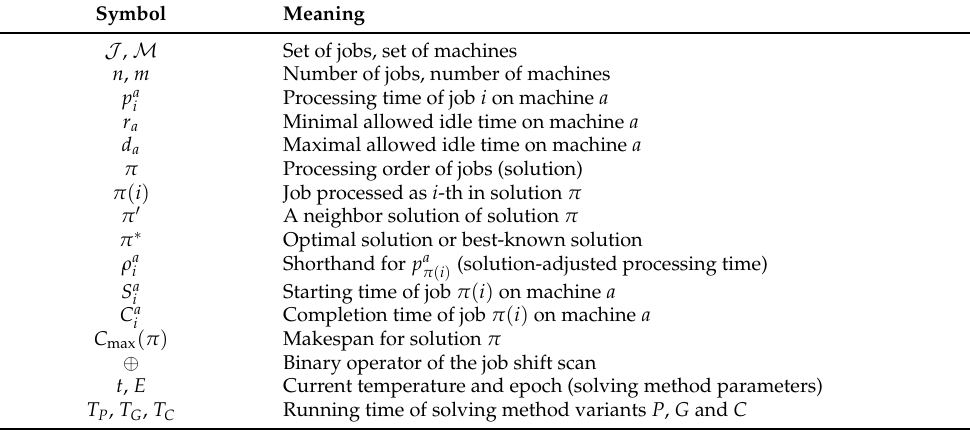
Table 1. Summary of